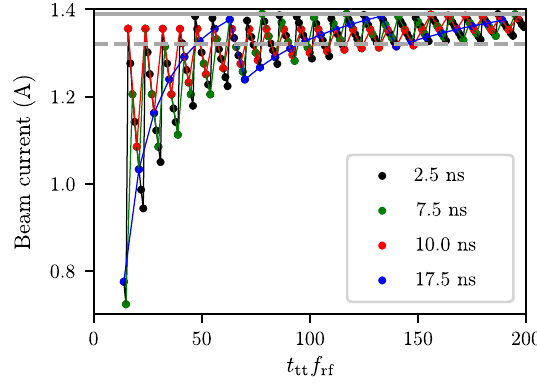
FIG. 20. Dependence of the total beam current in the resonant cases on the train spacing for different bunch spacings. The solid line corresponds to the design current J A ¼ 1 . 39 A, and the dashed line is at 0 . 95 × J A .